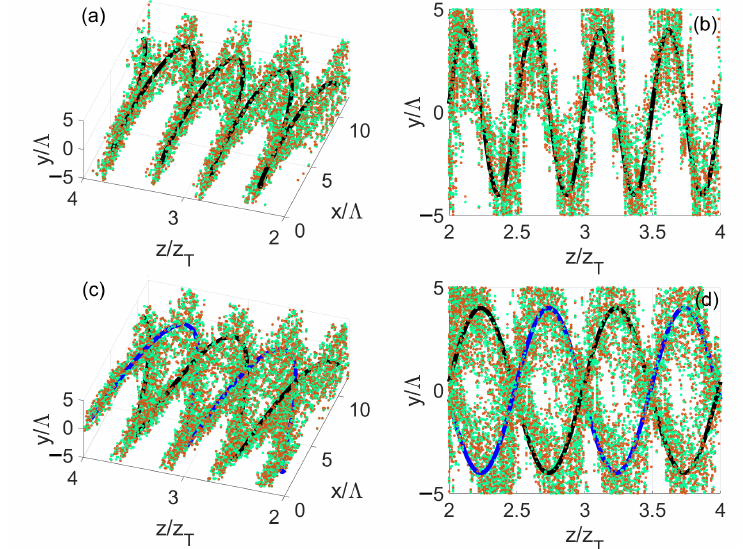
Figure 3. Calculated positions of positive (green) and negative (red) optical singularities behind FSG with topological charges p = + 1 ( a , b ) and p = + 2 ( c , d ). Solid curves show approximated helical traces of locus of points corresponding to the OS